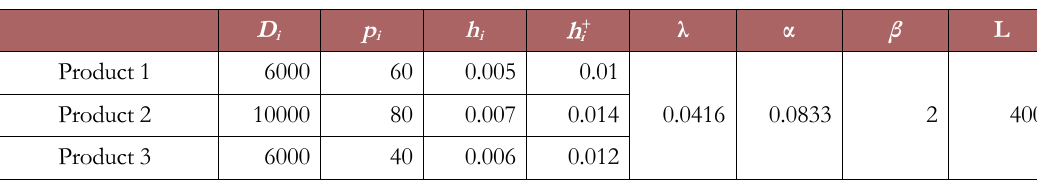
Table 2. The parameters of production and system